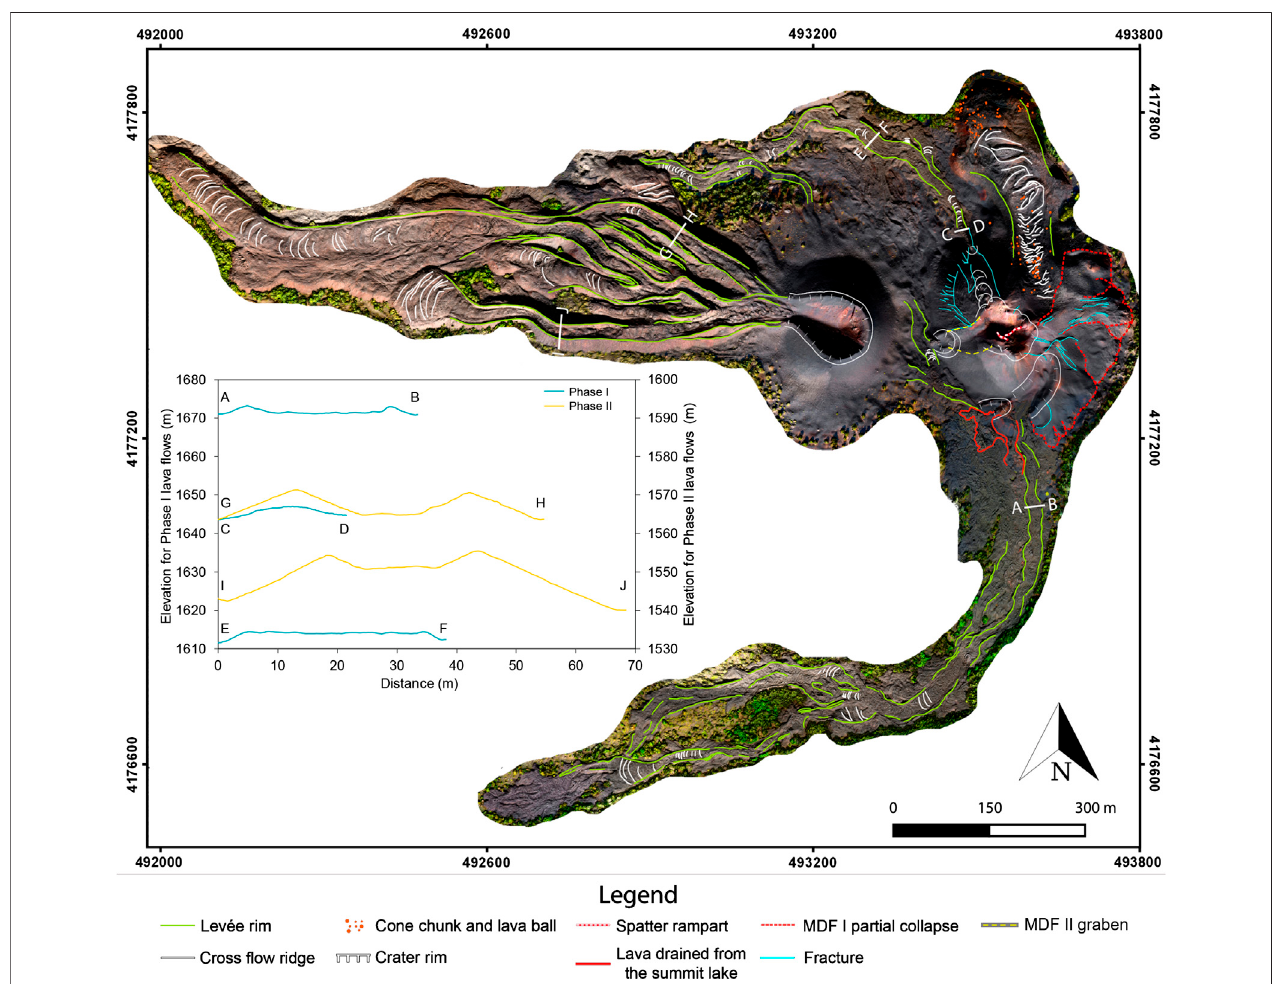
FIGURE3| Structuralmap oftheJanuary – March1974west fl ankeruptionofMountEtnaoverlainontheorthophotoofFavalli etal.(2018).Insetrepresentscross- unit pro fi les,takenperpendicularto fl owdirection, toshowtheoverallshape oflavaunitsassociatedwitheach phase: Pro fi lesA-B(Unit1.7),C-D(Unit1.10,atvent)and E-F (Unit 1.10, medial) are for Phase I, and G-H (Unit 2.2) and I-J (Unit 2.4) are for Phase II.